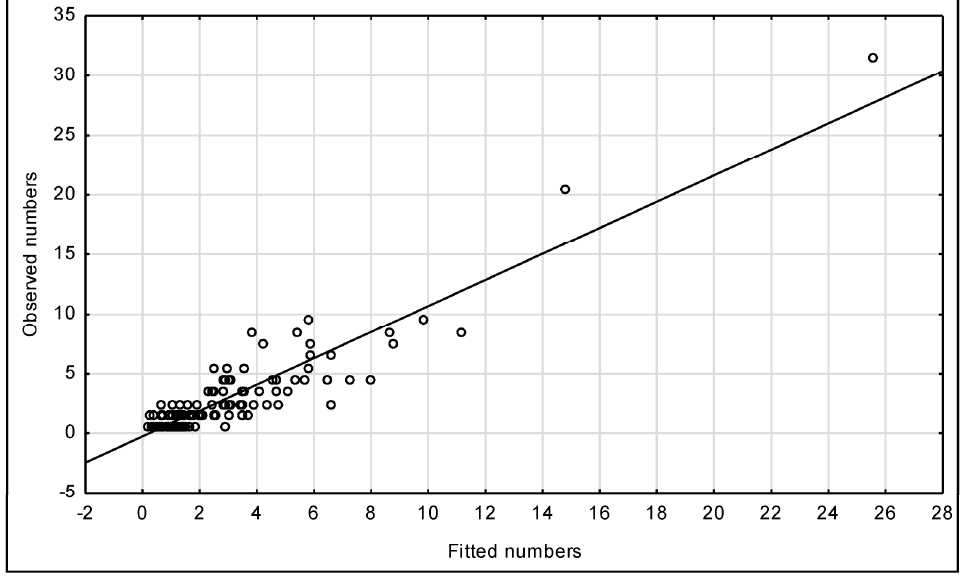
Figure 4. Distribution graph of observed frequencies versus fitted frequencies.